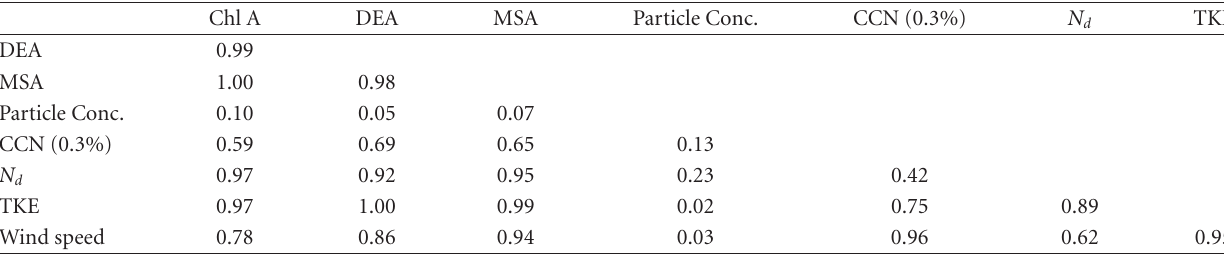
Table 1: Summary of correlative relationships ( r 2 ) between ocean chlorophyll A, marine aerosols, and stratocumulus clouds during the three-week MASE II field campaign in July 2007, during which chlorophyll A levels ranged between 1.01–3.58 mgm − 3 . Owing to the short duration of the study and limited measurements of chlorophyll A ( n = 3), all data have been averaged to correspond to the time durations corresponding to each chlorophyll A measurement. Details related to the mean, standard deviation, and range of values of these parameters are discussed in detail by Sorooshian et al. [17]. (Chl A = chlorophyll A; DEA = diethylamine; MSA = methanesulfonate; N d = cloud drop number concentration; TKE = turbulent kinetic energy). Chl A DEA MSA Particle Conc. CCN (0.3%) N